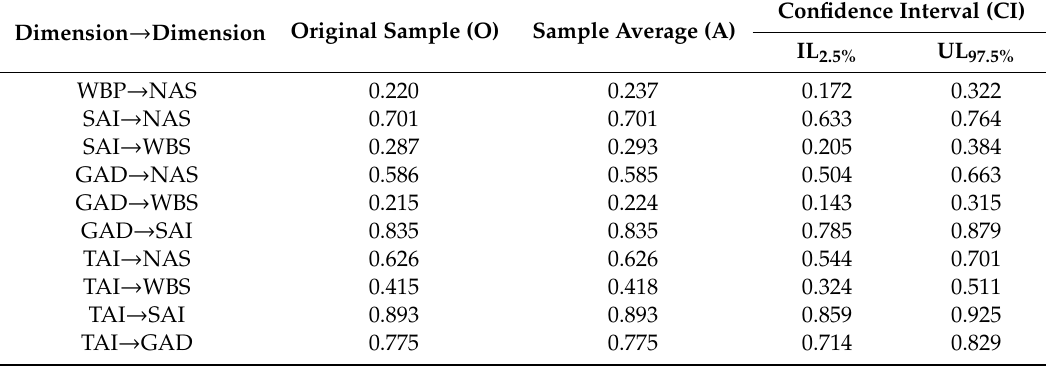
Table 9. Confidence interval for HTMT for 5000